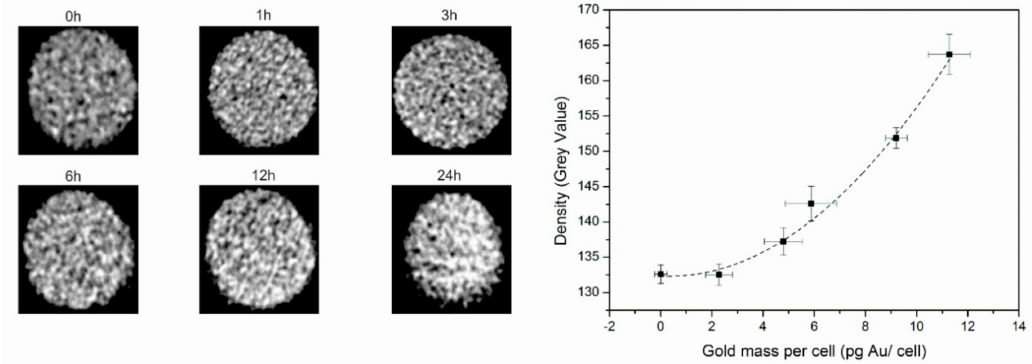
Figure 4. Left : CT images of an agar phantom loaded with tumor cells (n = 3) incubated for di ff erent time points with the nanostars. Right : CT signal quantified as density (grey values) plotted for the di ff erent gold masses per cell, where the dotted line suggests an exponential relation between those 2